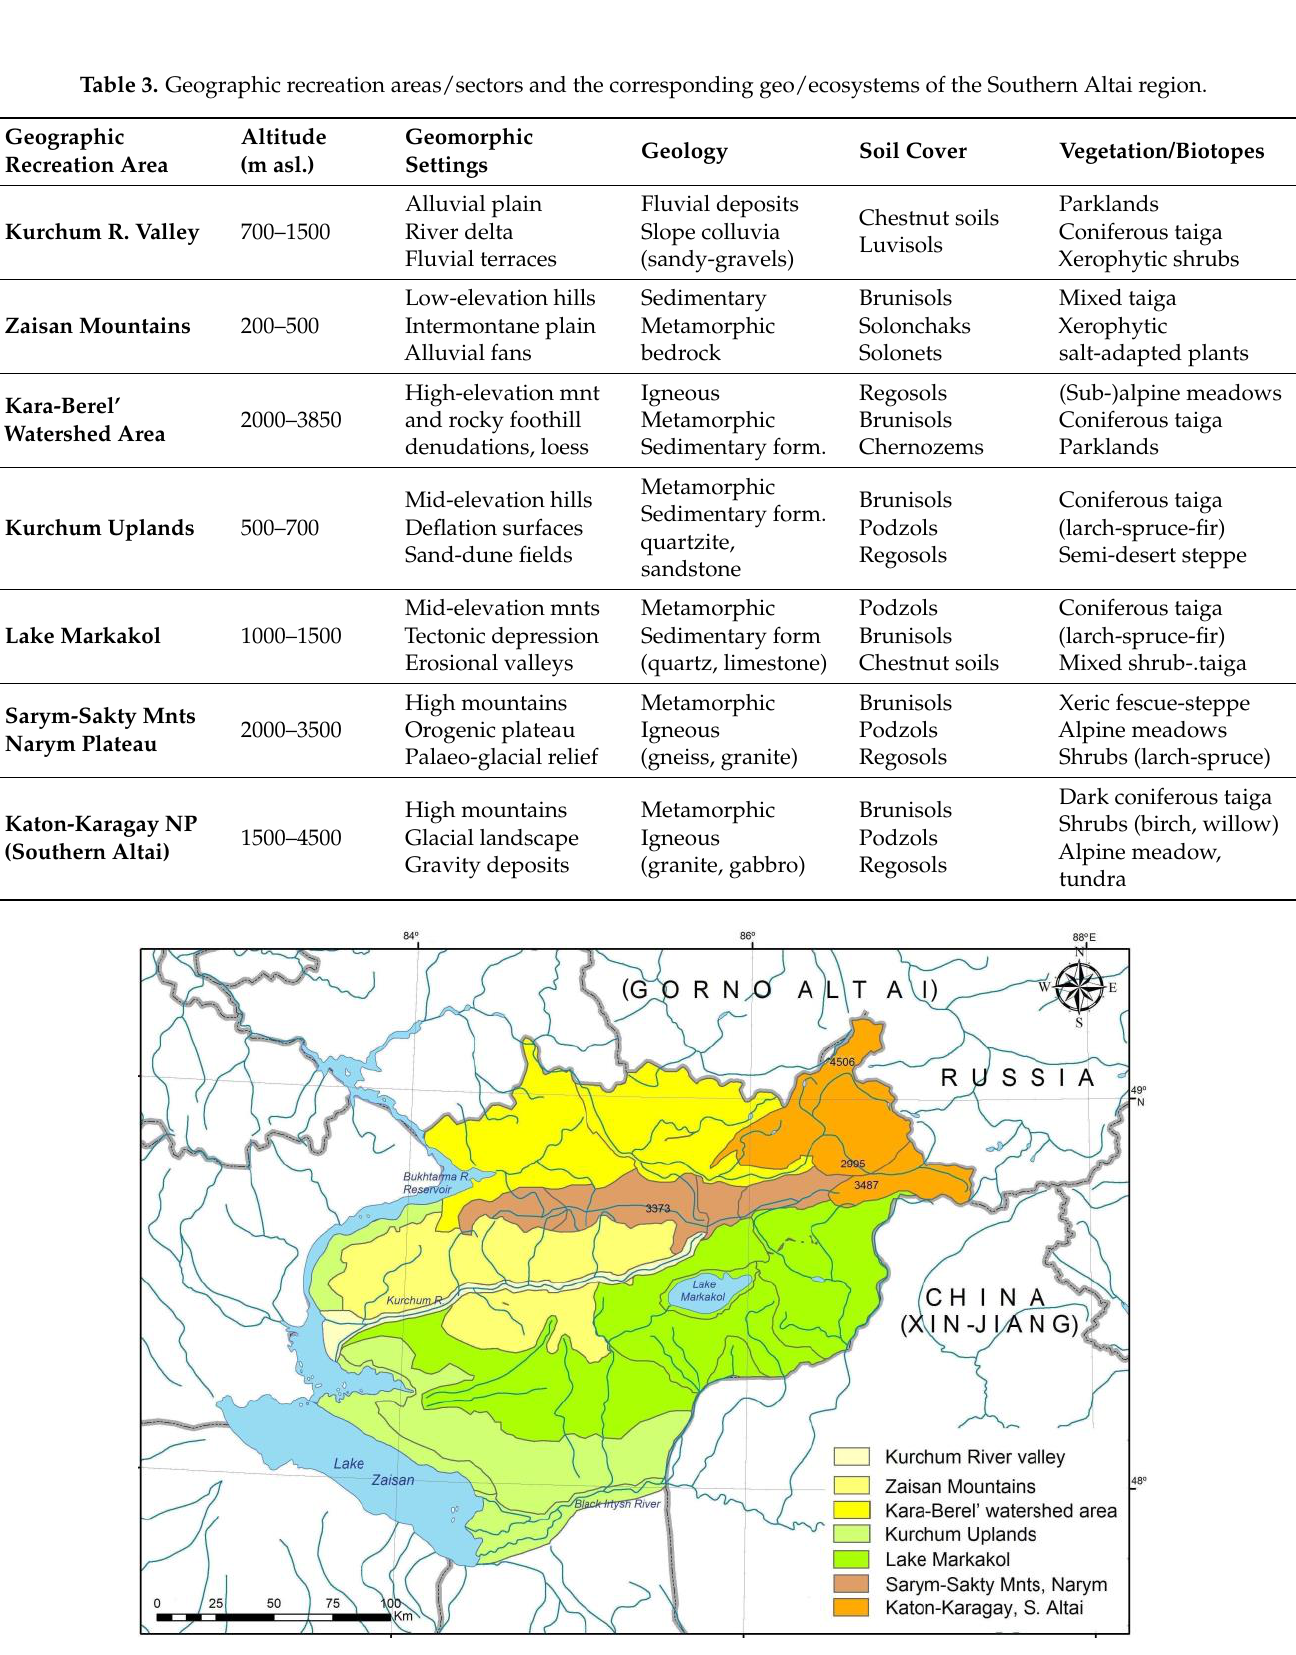
Figure 5. Generated model map of the geo/ecotourism potential and the recreation attractiveness on the territory of eastern Kazakhstan (the Southern Altai area). 5. Discussion: The Altai Geo- and Eco-Tourism Sustainability and Perspectives